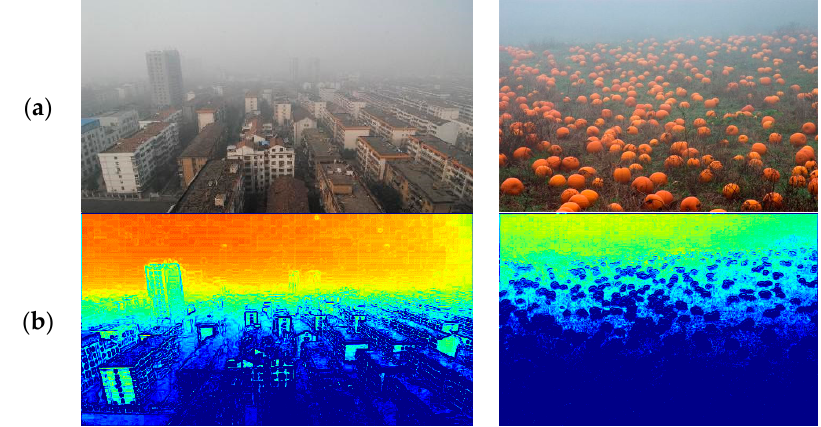
Figure 2. Hazy images and the corresponding haze density feature maps. ( a ): hazy images. ( b ): the corresponding haze density feature mapsobtained via Equation (4).